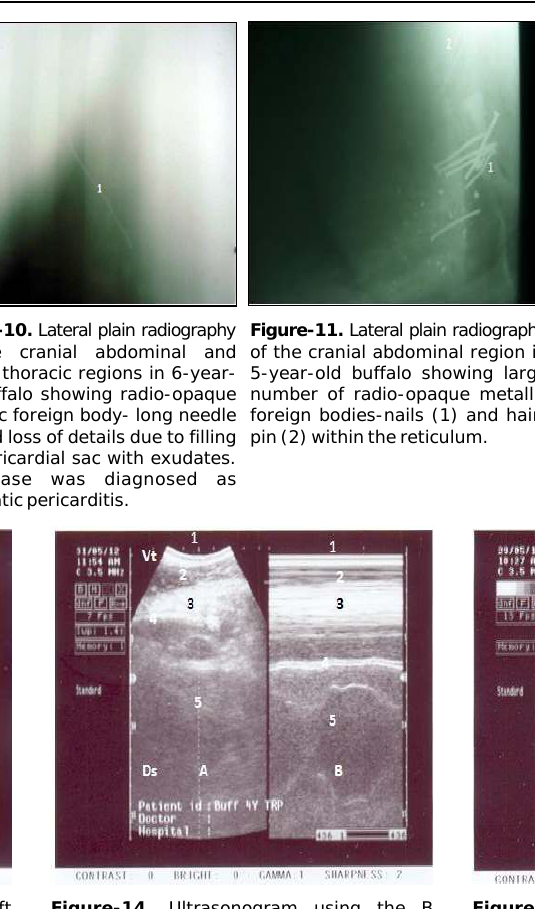
Figure-13. Ultrasonogram at the left parasternal region of 6-year-old healthy buffalo showing the reticulum (re) and cranial sac of the rumen (ru).